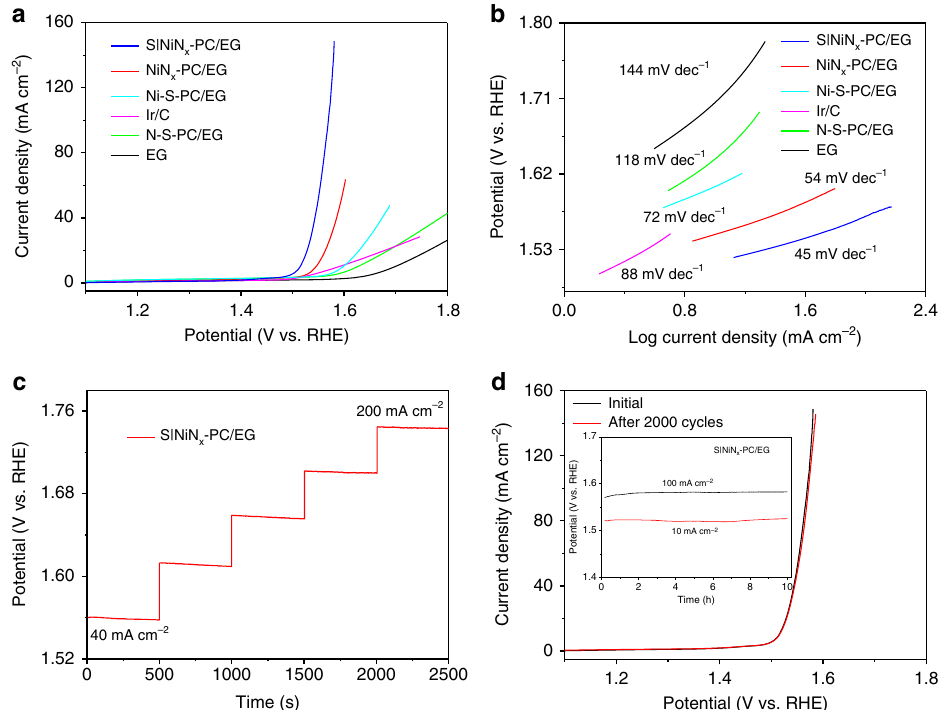
Fig. 2 Electrocatalytic OER performance. a Polarization curves of EG, NiN x − PC/EG, Ni-S − PC/EG, N-S − PC/EG, S|NiN x − PC/EG, and Ir/C for OER. b The corresponding Tafel plots. c Multi-current electrochemical process of S|NiN x − PC/EG. d Polarization curves of S|NiN x − PC/EG before and after 2000 cycles. Inset: Chronopotentiometry curves of S|NiN x − PC/EG under different current densities of 10 and 100mAcm − 2 . All experiments were carried out in 1.0M